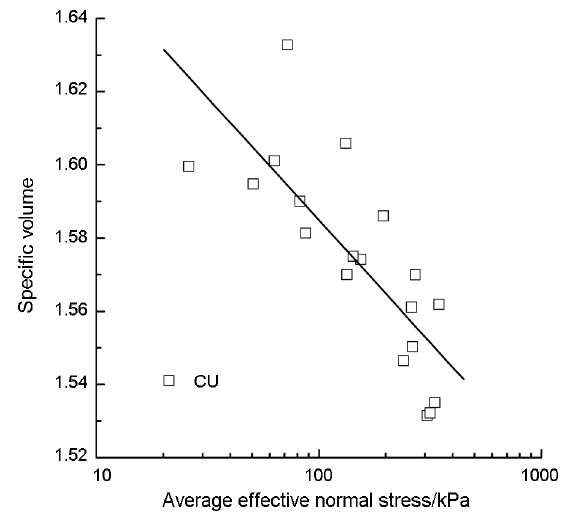
Fig. 3. Comparison between ' p and ν under different drainage conditions Fig. 4. Relationship between ' p and ν after